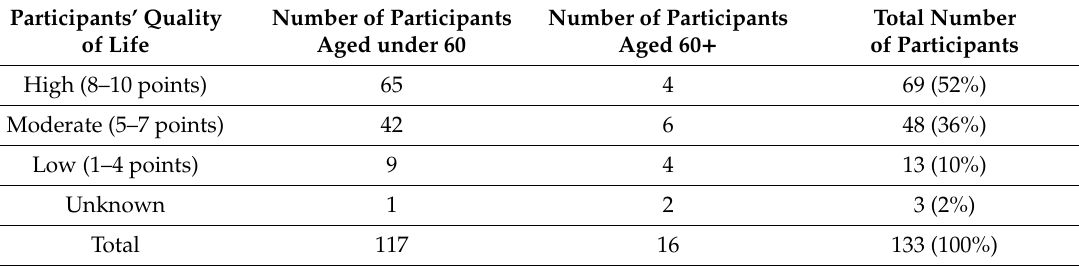
Table 4. Participants’ quality of life (self-reported) by age.